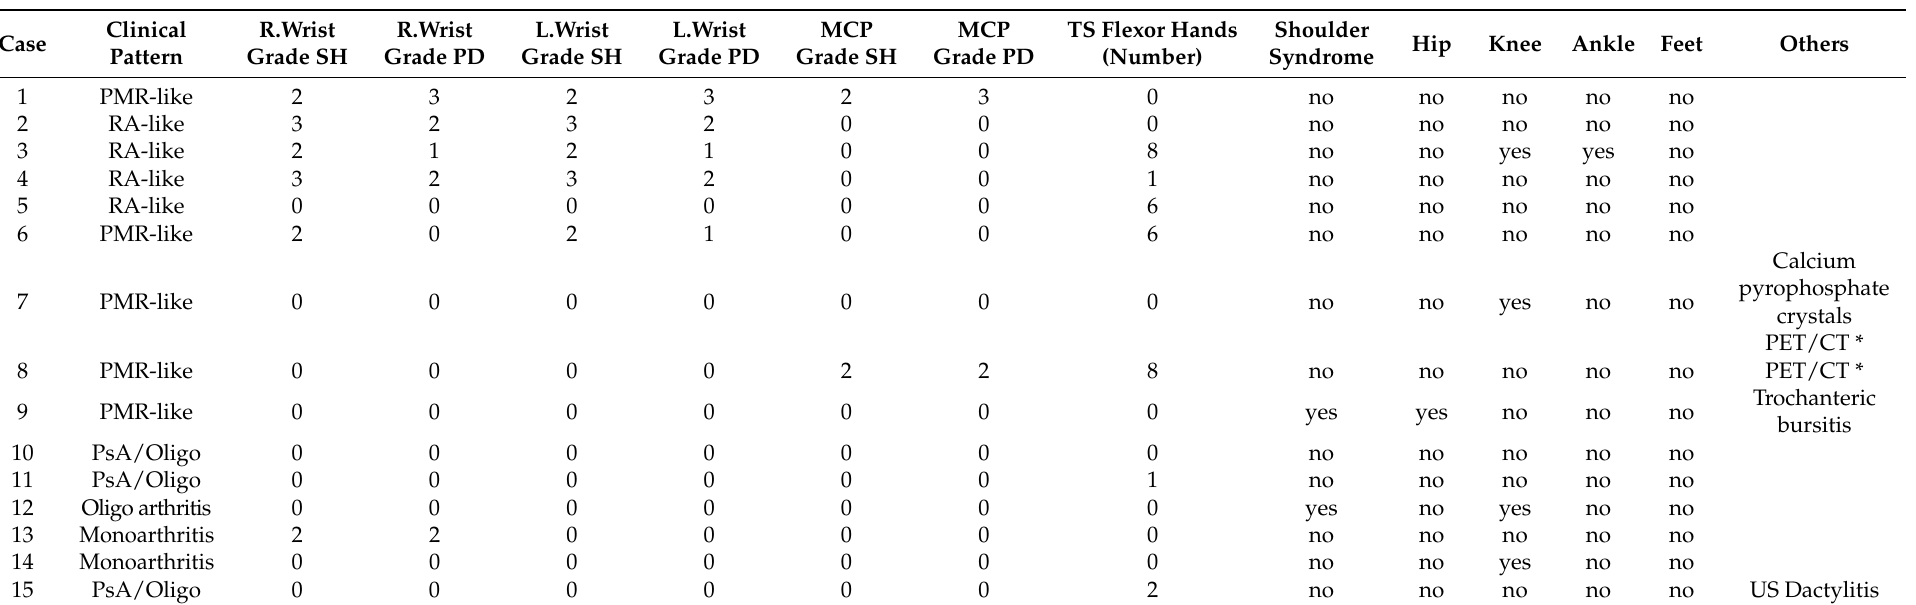
Table 3. US findings according to anatomical